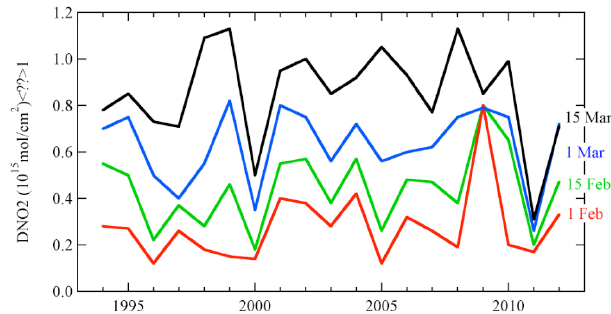
in the Arctic since 1994. Left: ERA-Interim minimum temperature north of 60°N at 475 K (red),